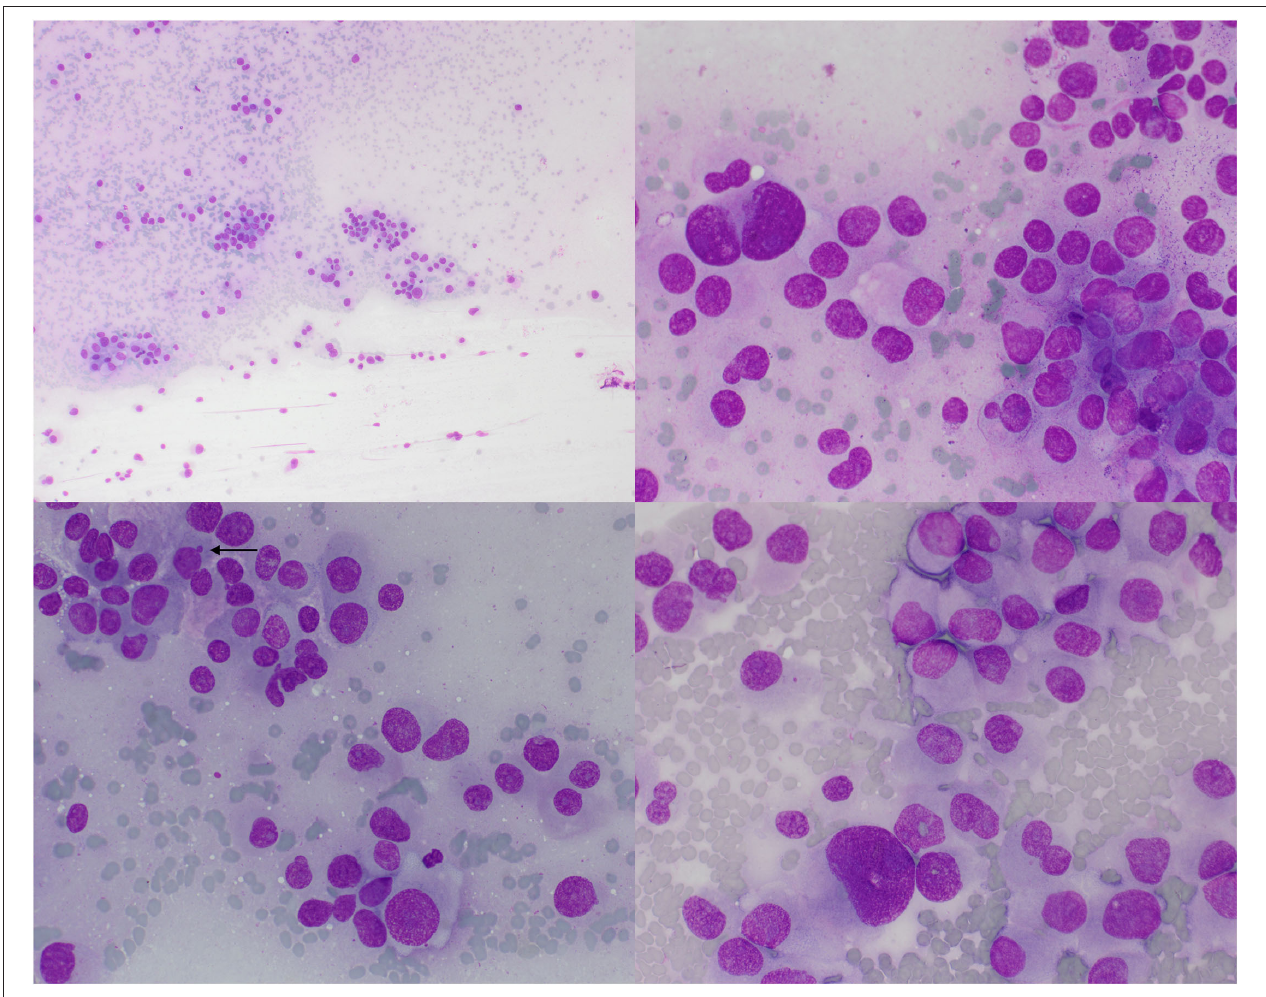
FIGURE 2 | Pituitary adenoma, cat. An imprint smear of the surgically excised pituitary mass revealed moderate numbers of neuroendocrine neoplastic cells arranged individually or in small aggregates. Cells have round to pleomorphic nuclei and a pale gray cytoplasm with poorly distinct borders and occasional vacuolization. The chromatin is finely stippled and contains multiple prominent nucleoli. Anisokaryosis is moderate to marked and occasional micronuclei are noted (arrow). Wright’s-Giemsa, 10 × (upper left) and 50 × objective lenses.